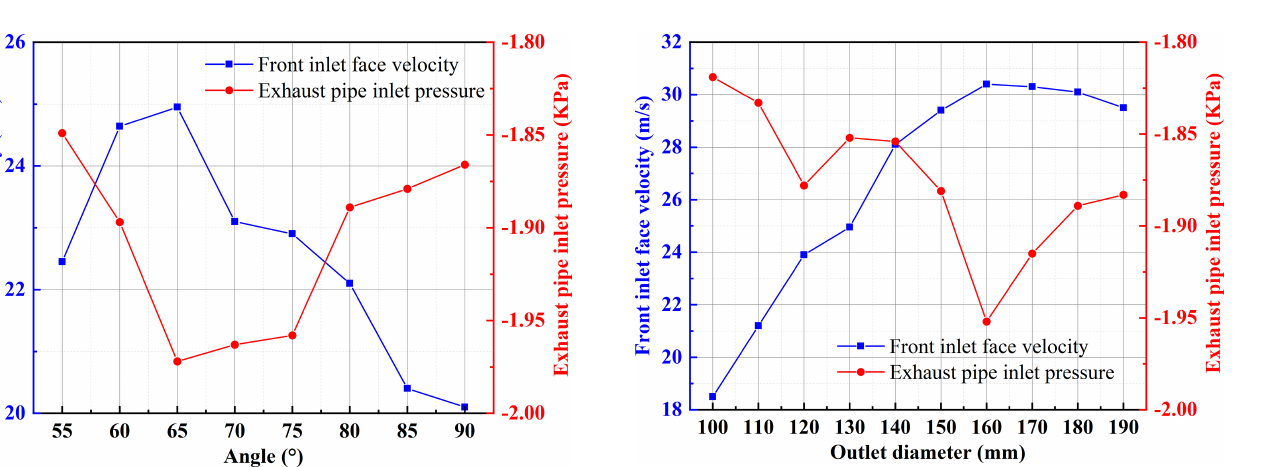
Figure 3. Influence of the angle of inclination of the front inlet surface on the flow field characteristics.